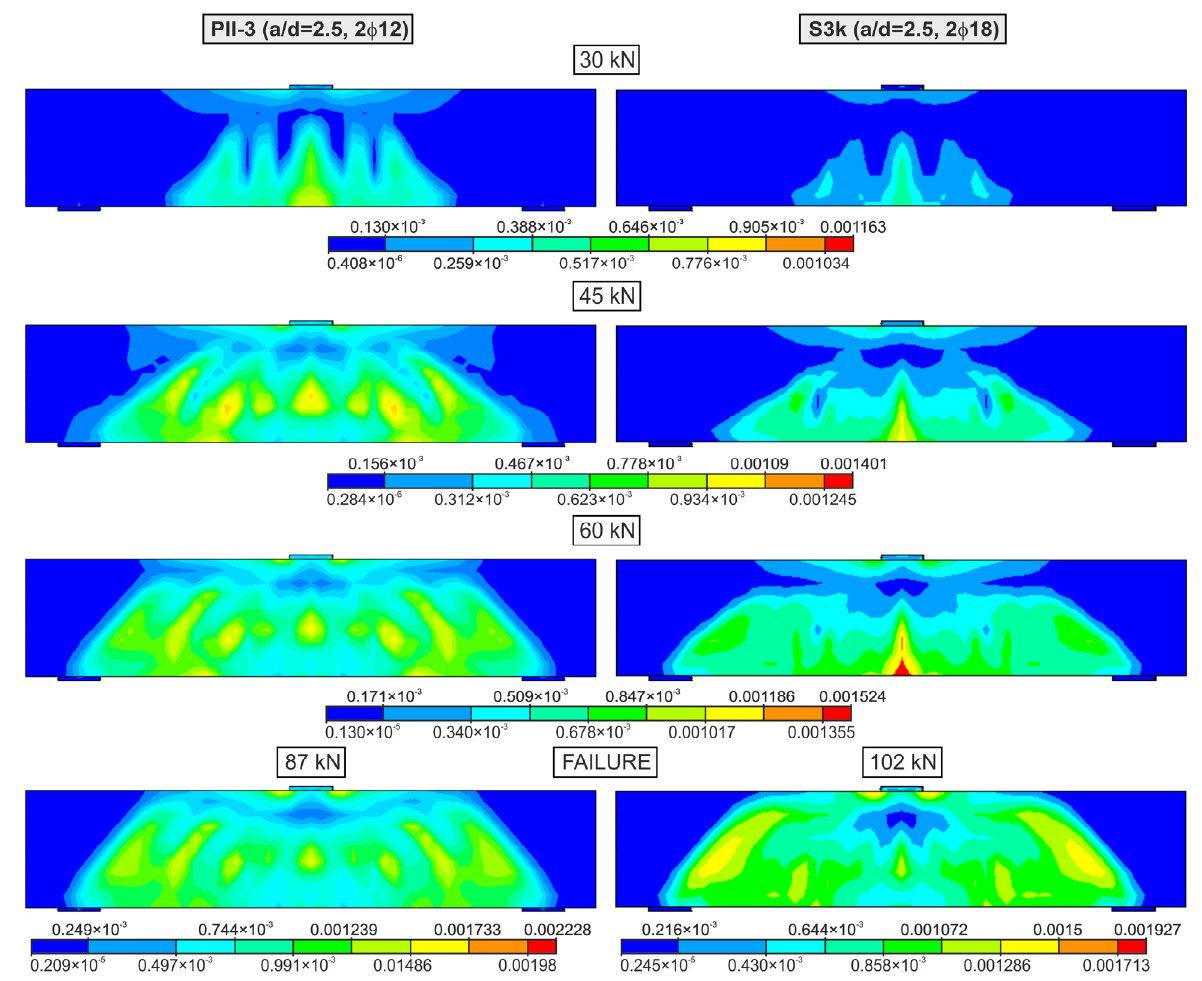
Figure 11. Total mechanical strain intensity for the slender beams PII-3 and S3k.